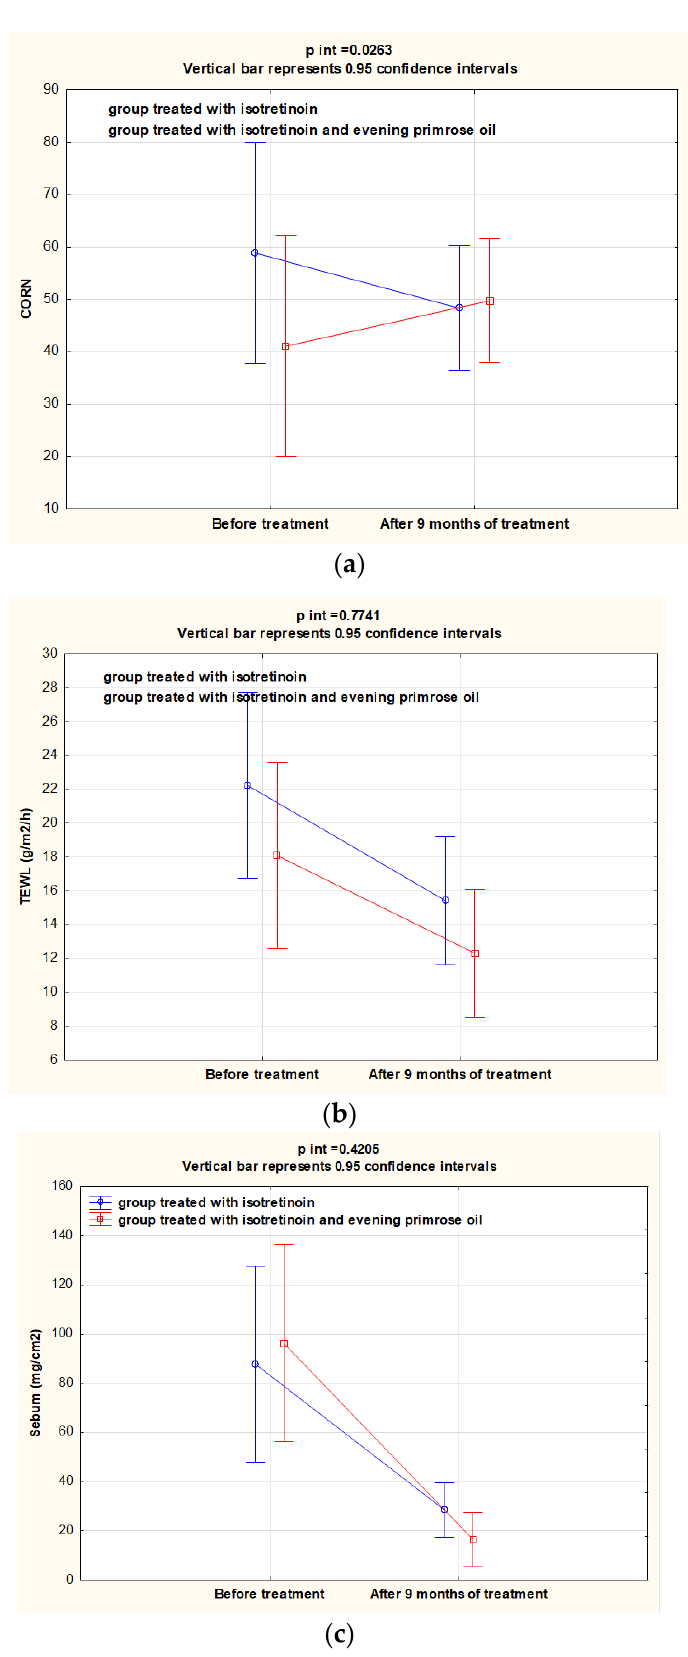
Figure 2. Changes in CORN ( a ), TEWL ( b ), sebum and ( c ) levels in groups I and IOW before and after intervention.